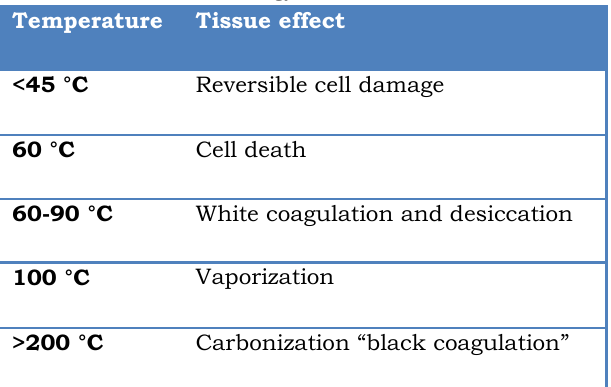
Table 2- Thermal energy and observed tissue